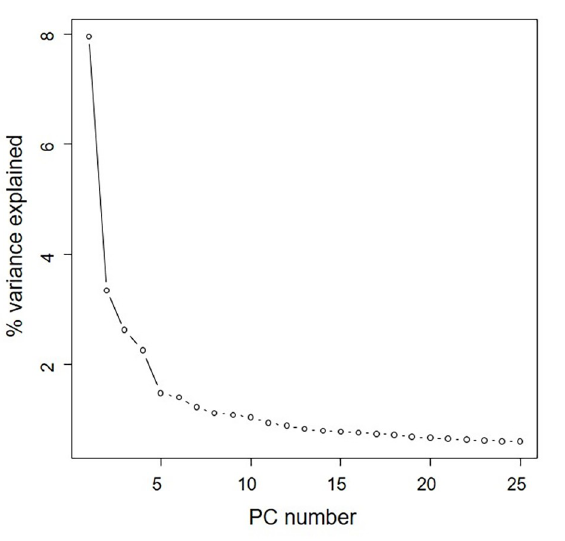
(412) had ovate leaflet shapes while only 18 had narrow leaflet shapes (Fig 7A and S3 Table). The 100-seed weight of these accessions ranged from 7.3 to 59.4 g (Fig 7C). tions. The proportion of each trait (flower color, hypocotyl color, pubescent color, growth habit, and leaflet shape) in the core collection to that in the total collection was approximately 18.1%. Specifically, proportions of these qualitative traits in the core collection to that in the total collection were around 15.8% in South Korea, 38% in North Korea, 51.4% in China,